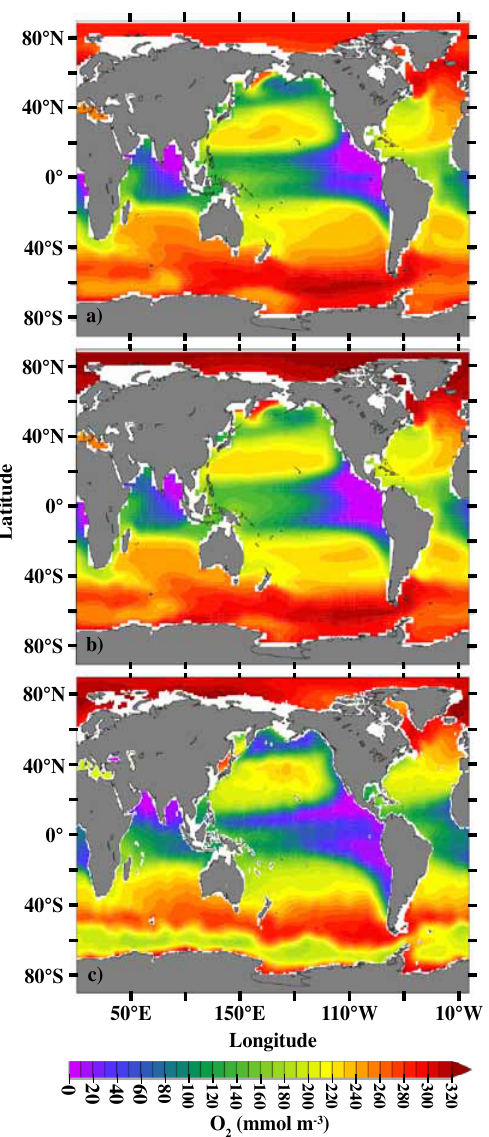
Fig. 10. Annual oxygen concentrations at ∼ 300m simulated with the new (a) and old (b) models and from the WOA09 database (c)